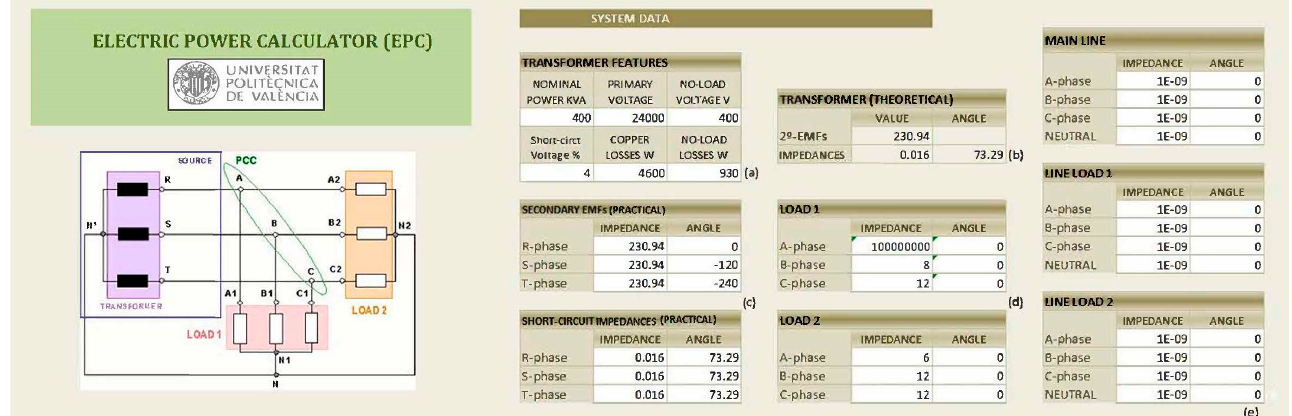
Figure 2. “System data“ screen: ( a ) transformer features; ( b ) theoretical values of transformer secondary EMFs and short-circuit impedances; ( c ) practical values of secondary EMFs and short-circuit impedances; ( d ) load impedances; and ( e ) line and neutral conductor impedances.